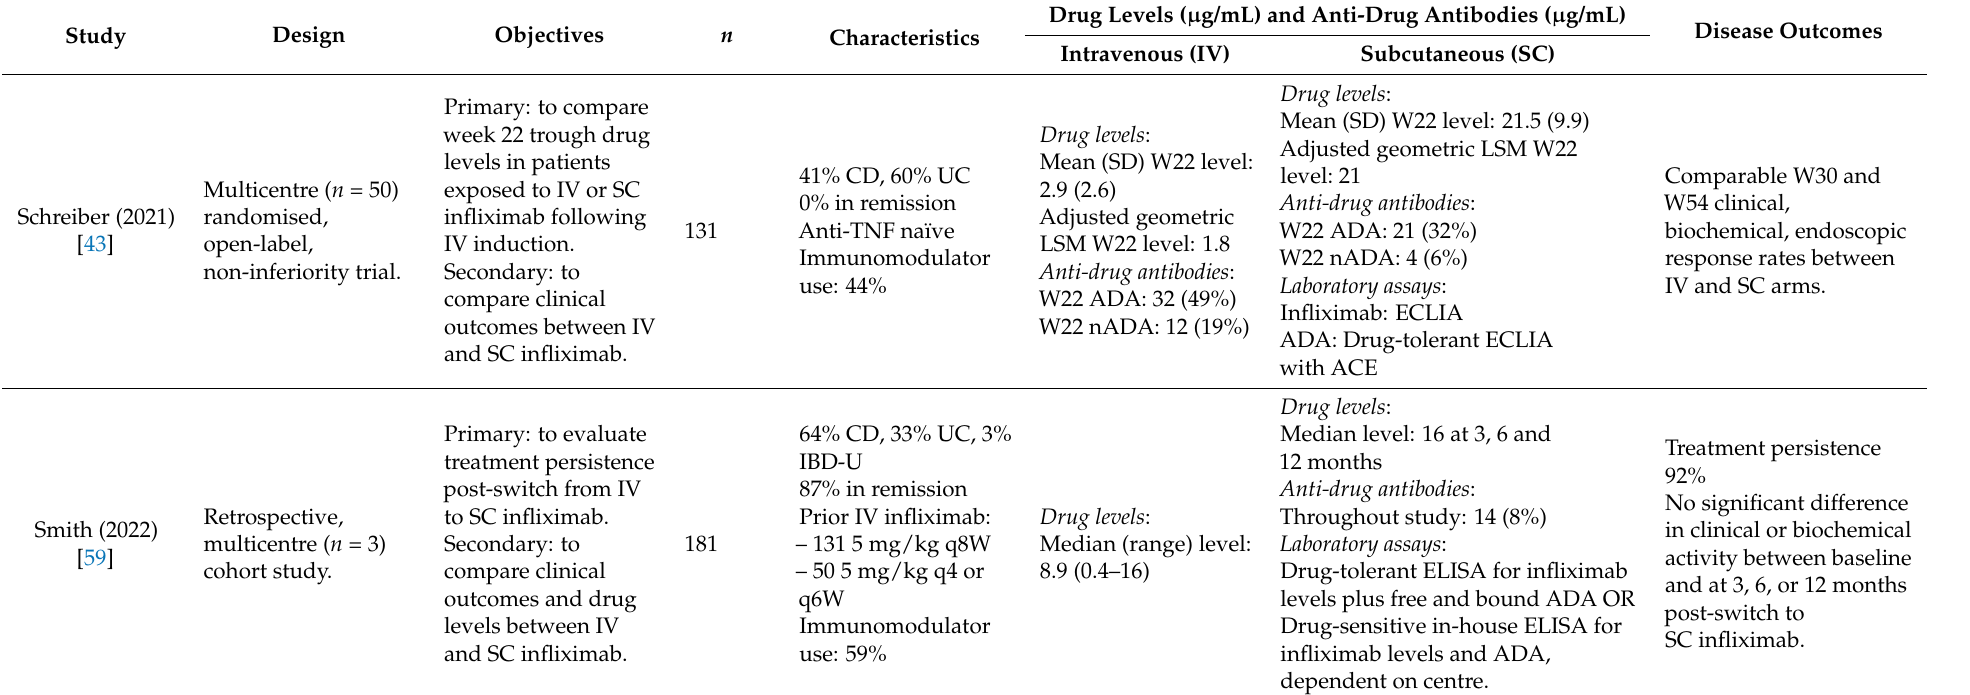
Table 1. Summary of original research reporting drug levels and disease outcomes in patients with inflammatory bowel disease (IBD) receiving subcutaneous infliximab (IFX; CT-P13) including full text and published